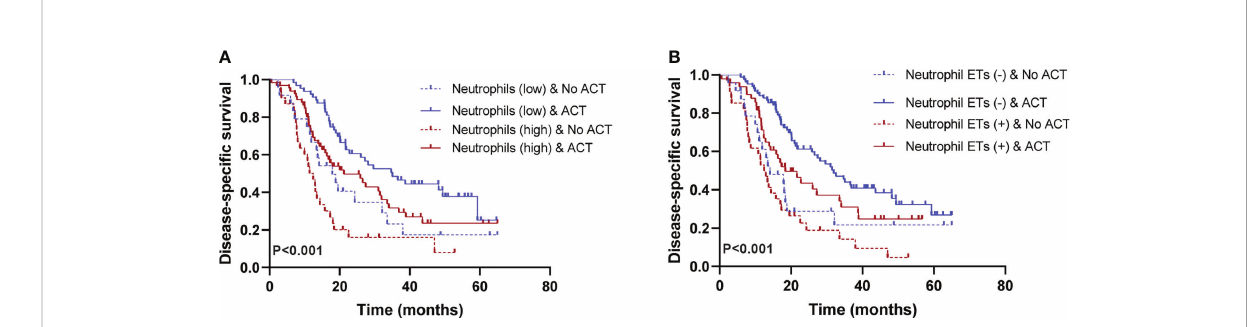
FIGURE 4 (A) Low neutrophil in fi ltration is associated with a positive response to adjuvant chemotherapy (ACT) (P<0.001). (B) Negative neutrophil ETs are associated with a positive response to ACT. Survival curves of ACT-treated patients with high/low neutrophil in fi ltration or positive/negative neutrophil ETs (P<0.001). (Log-rank test, n=205) ACT, adjuvant chemotherapy. P values <0.05 are